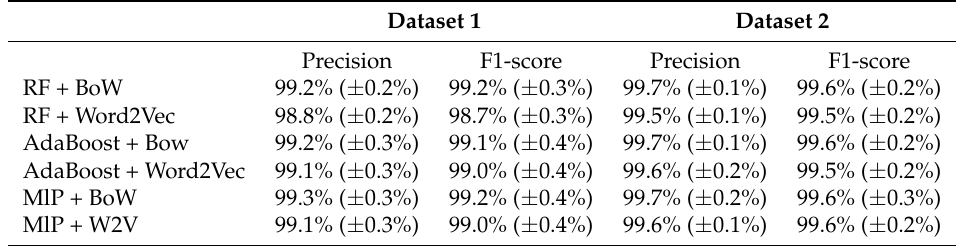
Table 3. Mean cross validation precision and f1-score of the classifiers which predict VAT codes (sent invoices). Standard deviation is reported in parentheses.